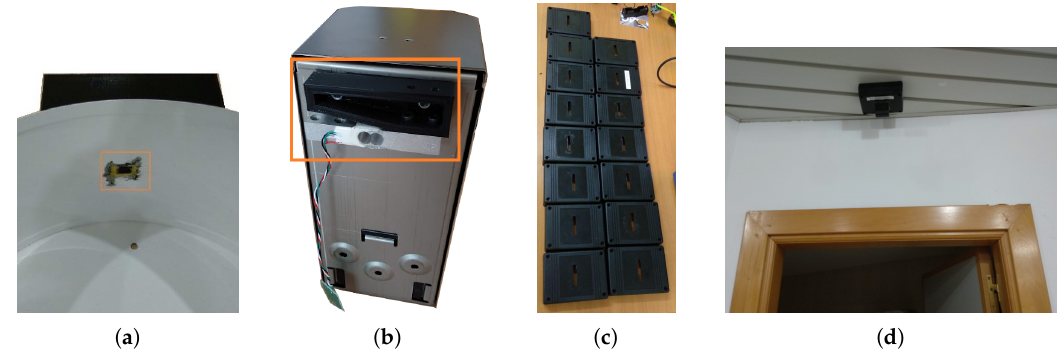
Figure 14. Device details: ( a ) paper dispenser, ( b ) load cell in soap dispenser, ( c ) people counter, and ( d ) people counter installation in